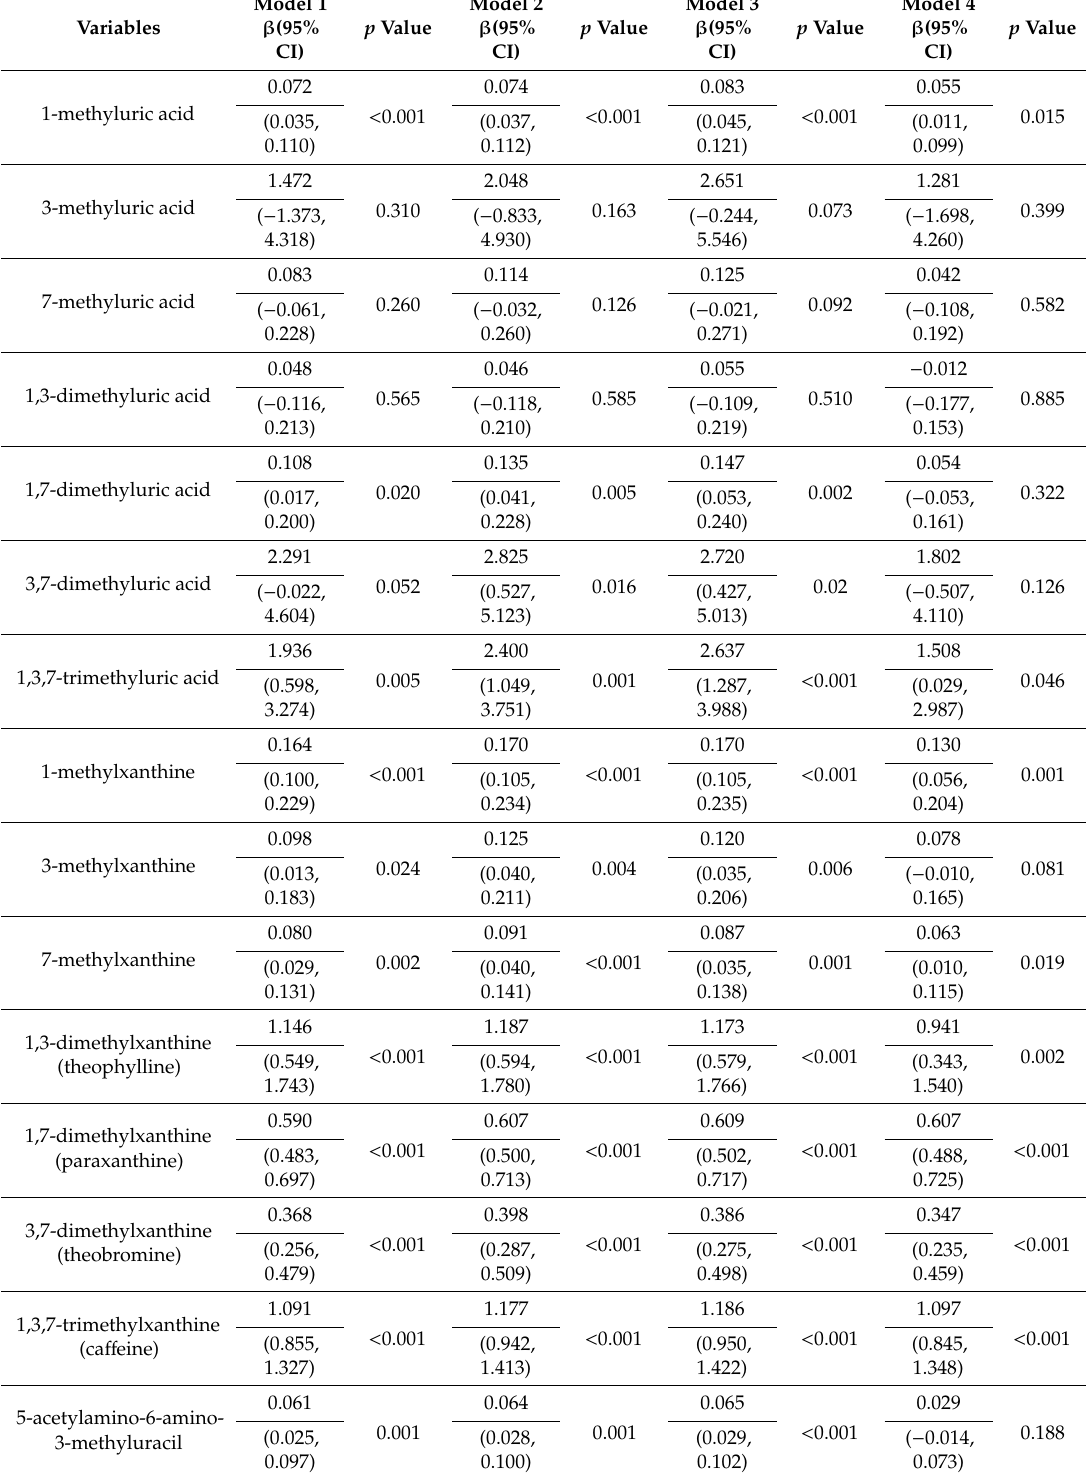
Table 2. Association between urinary ca ff eine metabolites and urine flow